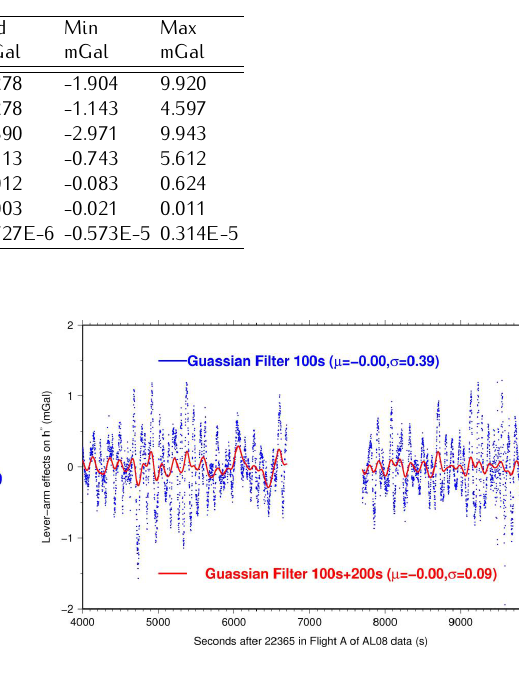
Figure 11. The filtered lever-arm errors along the track of Flight